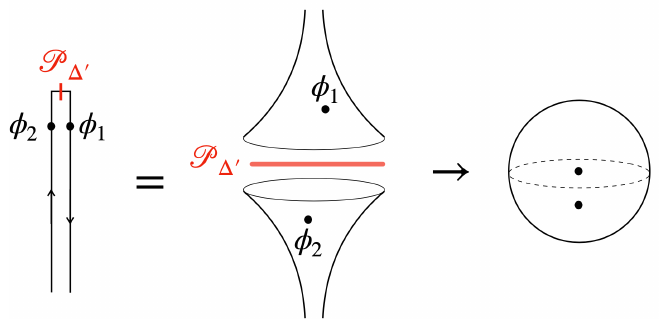
Figure 13 . A pictorial explanation of a resolution of identity and the proof of positivity. Left : the insertion of the projector corresponds to cutting the in-in path integral and inserting a set of states corresponding to the representation ∆ 0 . Middle: geometrically, this is equivalent to considering two sets of dS and inserting a resolution of identity. Right : to prove the positivity, we analytically continue the two points to sphere and place them symmetrically across the equator (the dashed